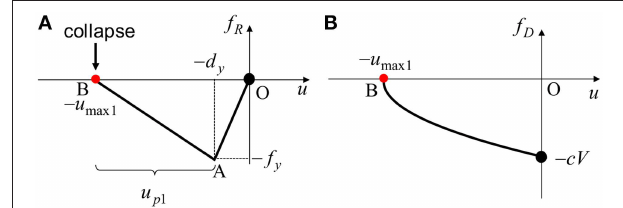
FIGURE 6 | Elastic-plastic response corresponding to Collapse Pattern 4, (A) Restoring force-deformation relation, (B) Approximate damping force-deformation relation (Collapse limit after first